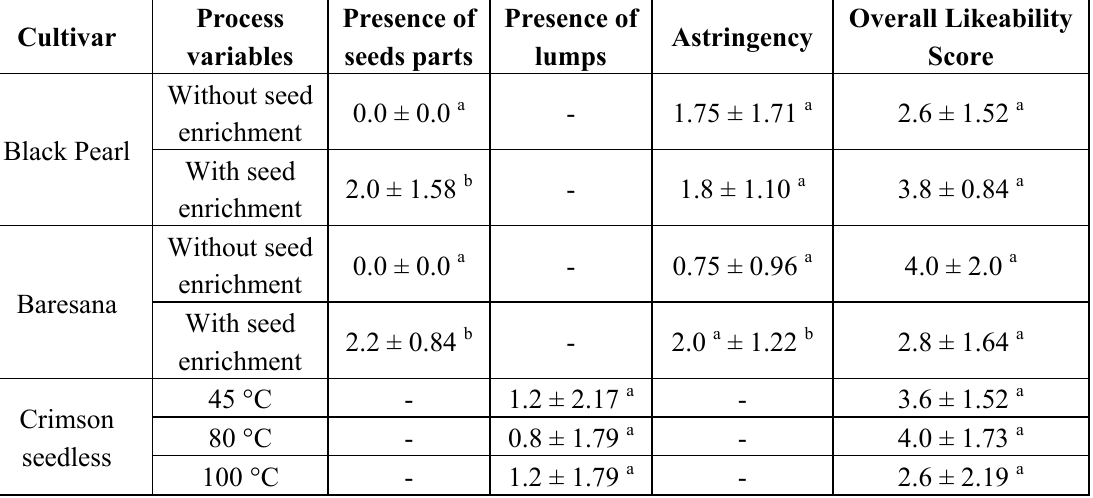
Table 1. Results of the sensorial analysis of the functional table grape-based smoothies.